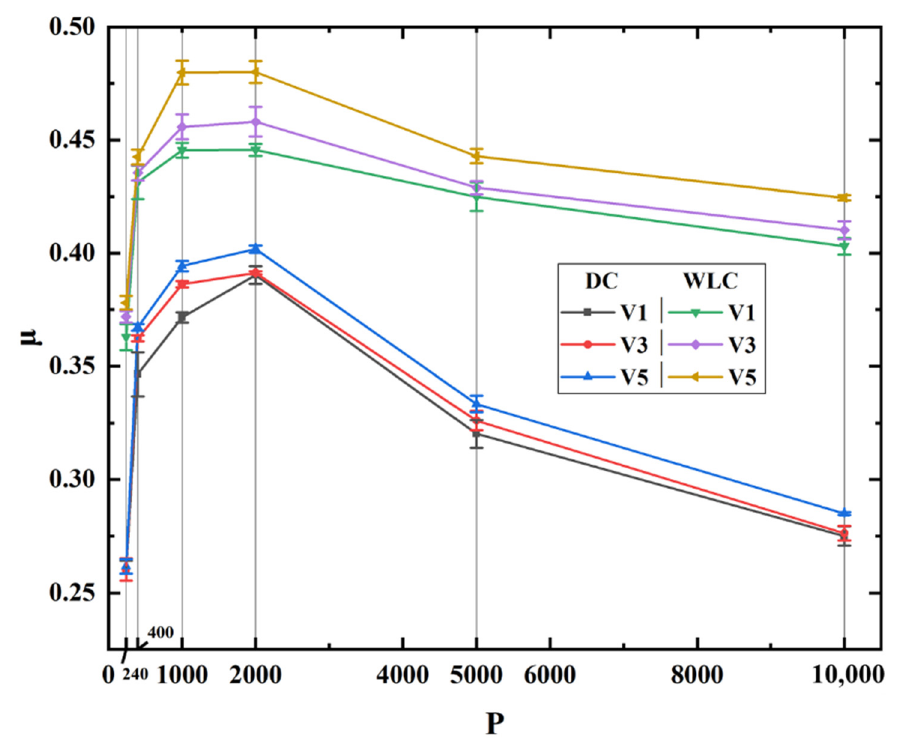
Figure 5. The relationship between the COF and the roughness. V1: 1 mm/s; V3: 3 mm/s; V5: 5